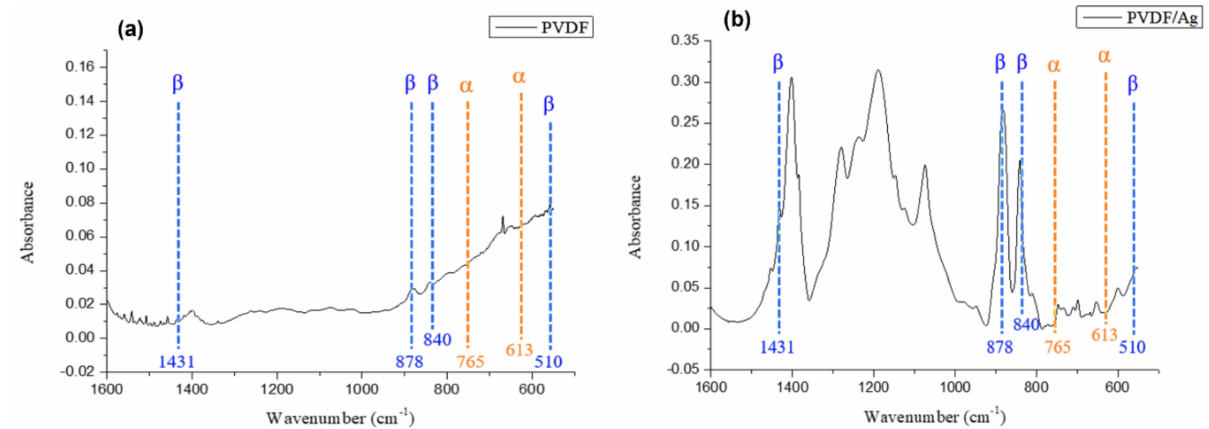
Figure 10. FTIR results of ( a ) 18 wt% of single PVDF and ( b ) with the addition of 6% Ag nanoparticles electrospinning solution after polarization.